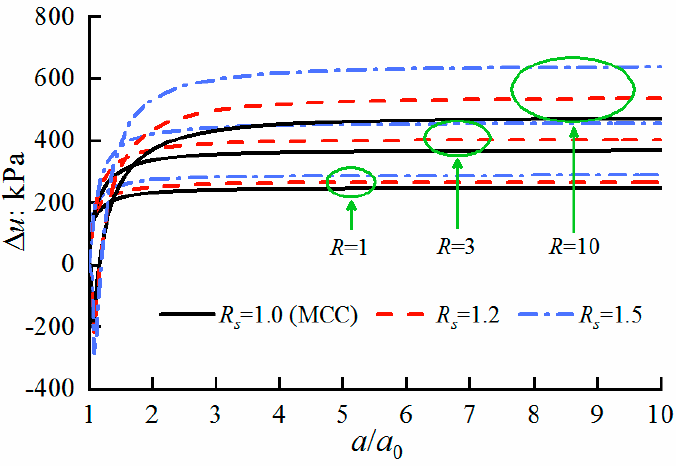
Figure 9. Relationship between the excess pore pressure Δ u and the cavity radius a / a 0